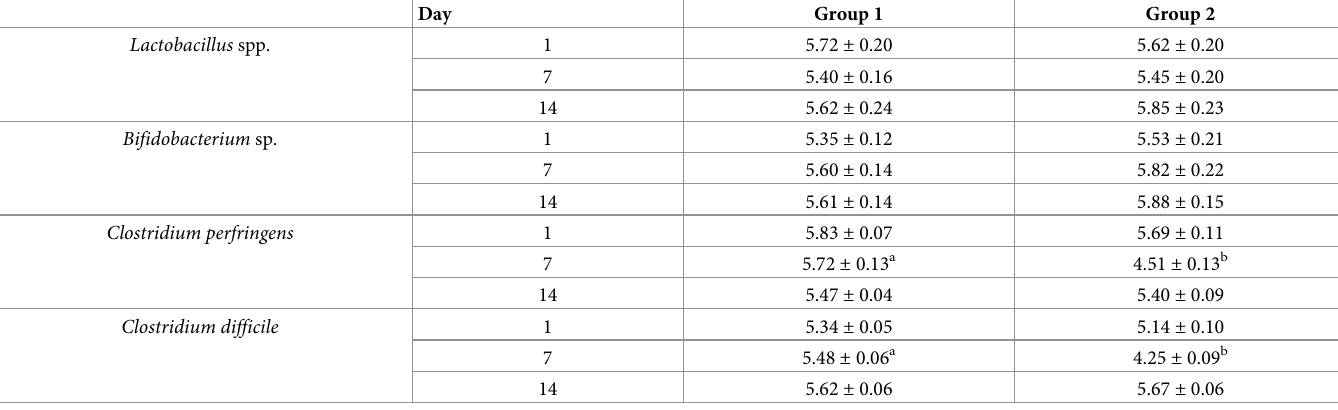
a, b Different letters within rows indicate differences between the treatment groups ( P <